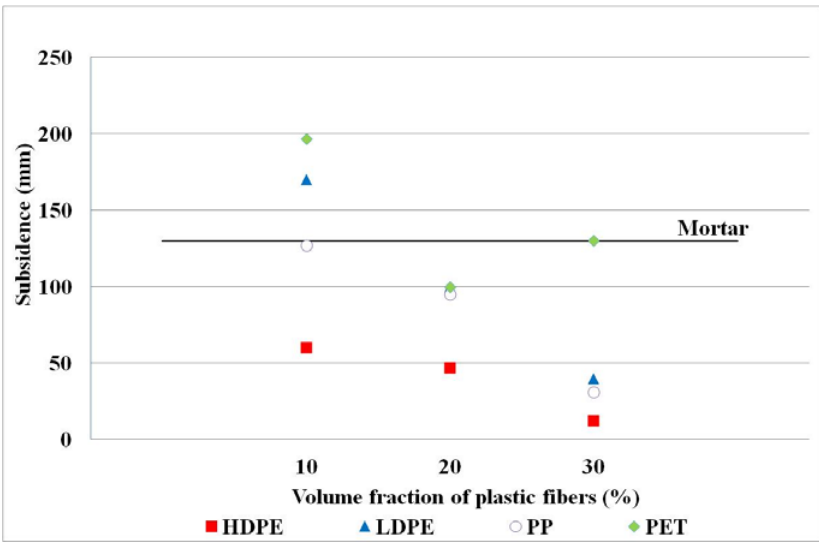
Figure 3. Workability of fresh concrete. The subsidence of mortar (control sample) is in the solid line.